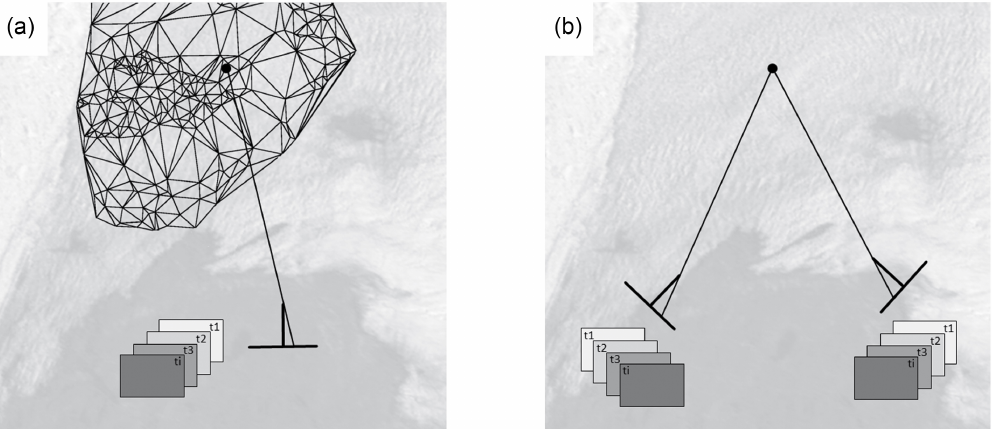
Figure 1. Monoscopic (a) vs. stereoscopic (b) image sequence